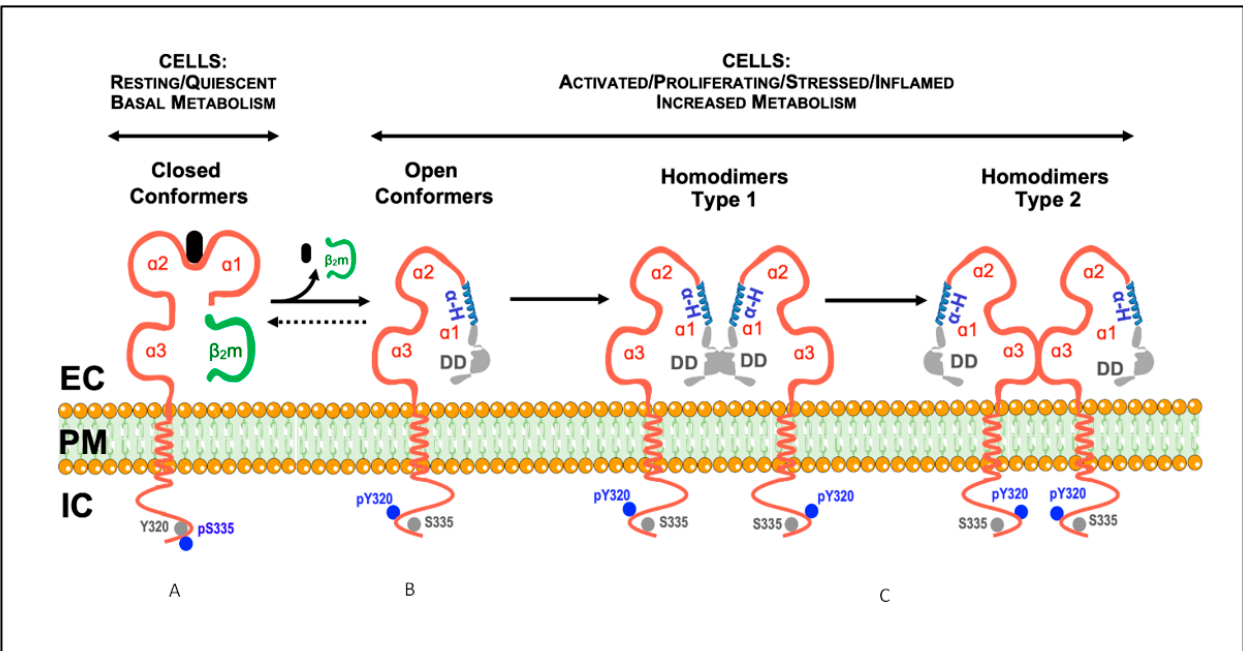
Figure 1. Model illustrating the described conformational states and cis-associations of cell surface MHC-I molecules. ( A ) Classical MHC-I molecules are trimeric composites of a transmembrane heavy chain ( α HC) organized into three domains ( α 1, α 2, and α 3), non-covalently associated with a light chain ( β 2m) and a small peptide ( A ). These trimeric structures are differentially expressed at the plasma membrane of nucleated cells, and are also designated as closed conformers [5]. The cytoplasmic domain of the α HC of closed conformers contains two conserved motifs: (1) a tyrosine residue at position 320 in all HLA-A and HLA-B alleles that appears to be de-phosphorylated in resting cells (Tyr320, grey circles); (2) a serine residue at position 335 in all HLA-I alleles that appears to be phosphorylated in vivo (pSer335, blue circles). ( B ) Upon physiological settings associated with an increased metabolic activity (e.g., activation, proliferation, differentiation, etc.), a fraction of the closed conformers dissociate from the β 2m and the peptide and generate free α HC, also known as open conformers. As a result, a physiological equilibrium exists where the closed/open conformers ratio decreases or increases depending on the metabolic state of the cell. Contrary to closed conformers, the cytoplasmic domain of the open conformers is serine de-phosphorylated (Ser335, grey circles) and tyrosine phosphorylated (pTyr320, blue circles). The phosphorylation status may allow membrane movement, localization and trafficking [5]. Thus, based on the current knowledge, pSer335 and pTyr320 may be considered as surrogate biomarkers of closed and open conformers, respectively (see [8–15], and text). ( C ) The open conformers formed at the plasma membrane of metabolically active cells may self cis -associate originating α HC homodimers, or hetero cis-associate originating α HC heterodimers (not shown, see Section 4). While some of these homodimers are non-covalently associated (see text), others are the result of the formation of disulfide bonds between unpaired cysteines located along the sequence of the α HC (see text). Depending on the orientation of the cis -association, two different homodimers may eventually form, type 1 and type 2. In this model, type 1 homodimers will preferentially be involved in trans-interactions with KIR and LILR receptors [5]. In contrast, type 2 homodimers, due to the flexibility of the α 1 domain, namely the polymorphic and ordered α -helix ( α -H, in blue), will favor cis -associations with nearby immune and non-immune receptors, such as CD8 αβ and the insulin receptor (see text). DD, disordered domain (in grey); EC, extracellular milieu; PM, plasma membrane; IC, intracellular milieu.